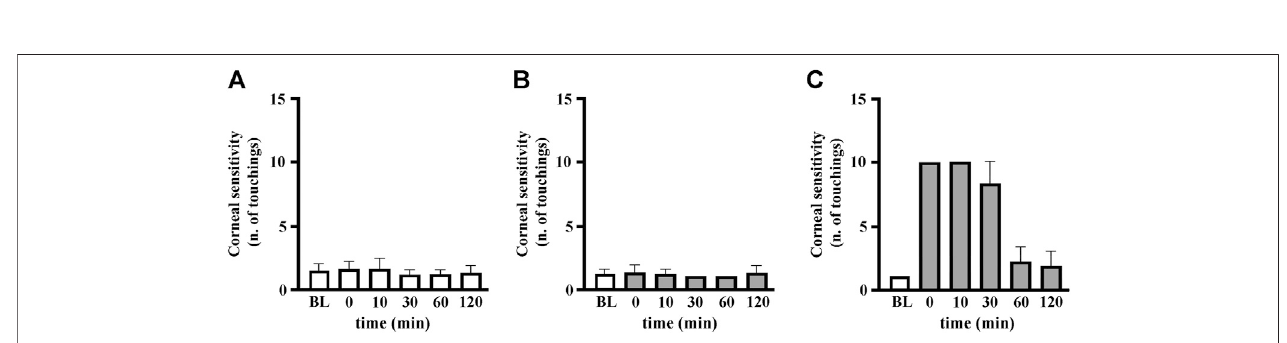
FIGURE 2 | Analgesic and not anesthetic activity of topical GBT. Rabbit eyes ( n (cid:2) 6) were instilled with PBS (A) , 2% GBT (B) or 0.4% BNX (C) , and corneal sensitivity was evaluated at different times by the number of touchings at minimal extension (0.75 mm) eliciting a blinking re fl ex. BL, baseline.